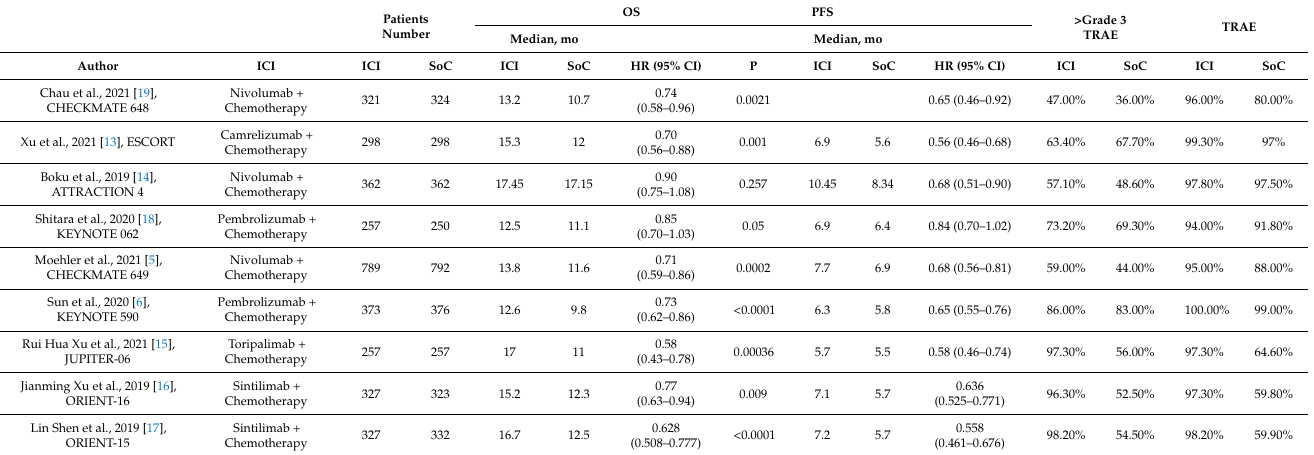
Table 1. Included studies in the subgroup immunotherapy plus chemotherapy vs. chemotherapy.